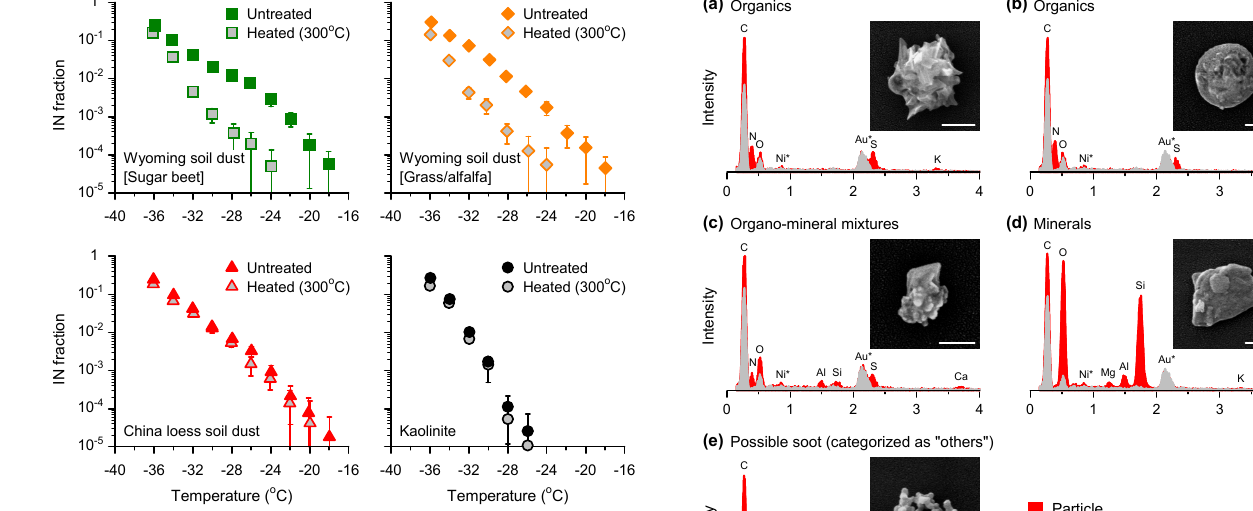
Figure 3. Same as Fig. 2a, but for the data for untreated and heated samples.